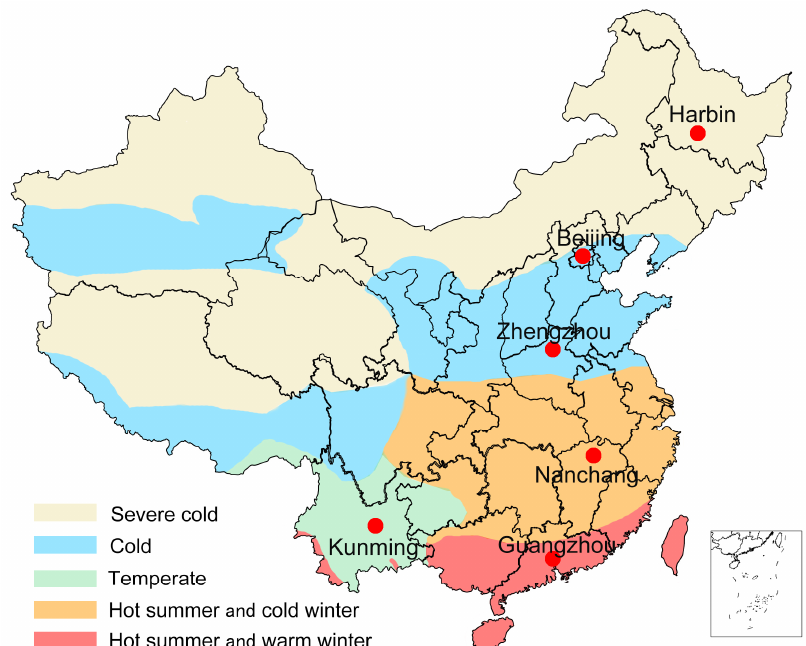
Figure 3. Map showing the climate zones of China and the six selected